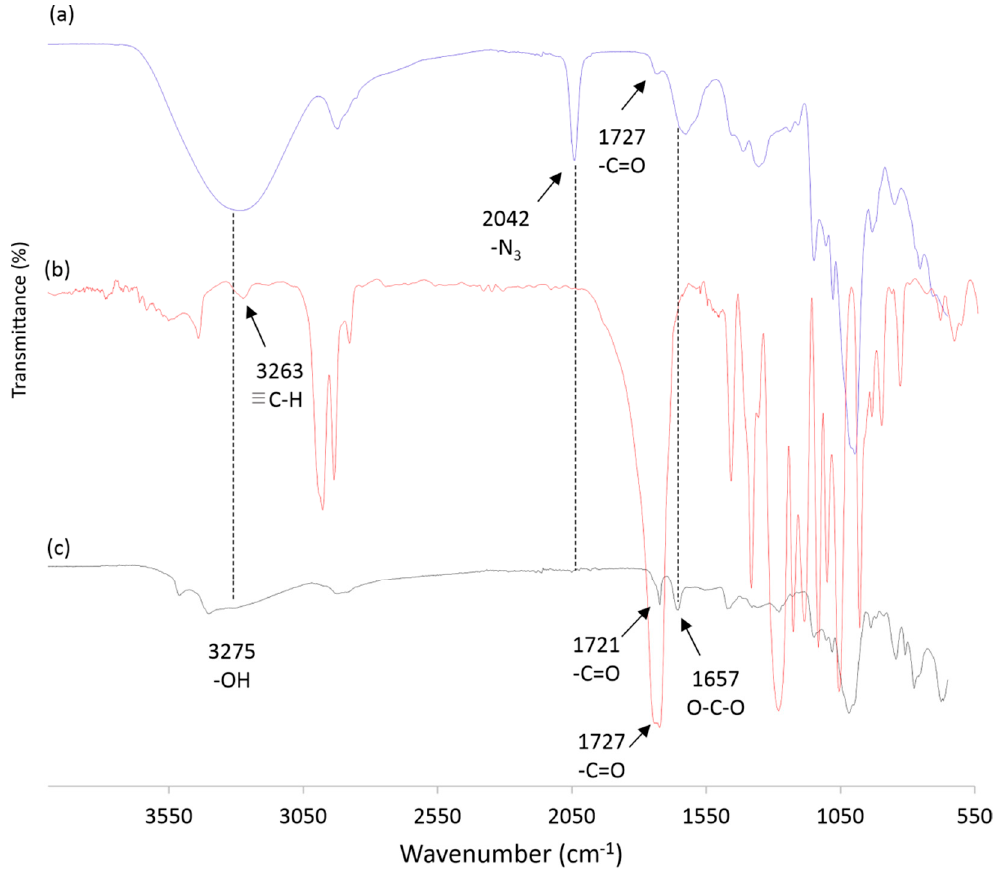
Figure 5. FTIR spectra of PullN 3 (a), PHBHV-alkyne (b) and Pull- g -PHBHV (c).